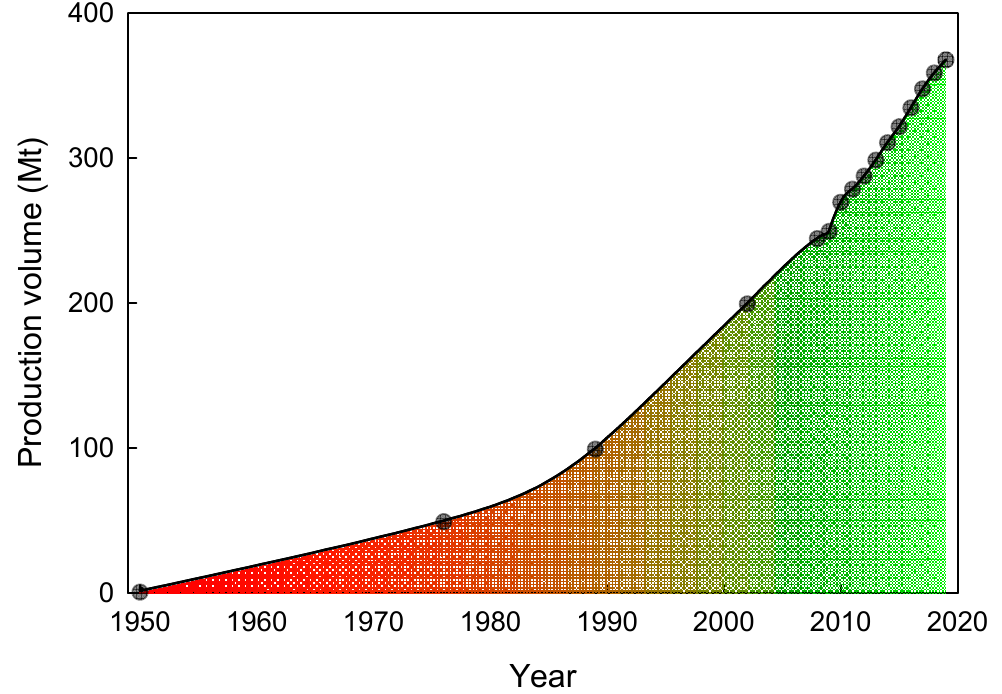
Figure 4. Production volume of plastics worldwide from 1950 to 2019 [18].